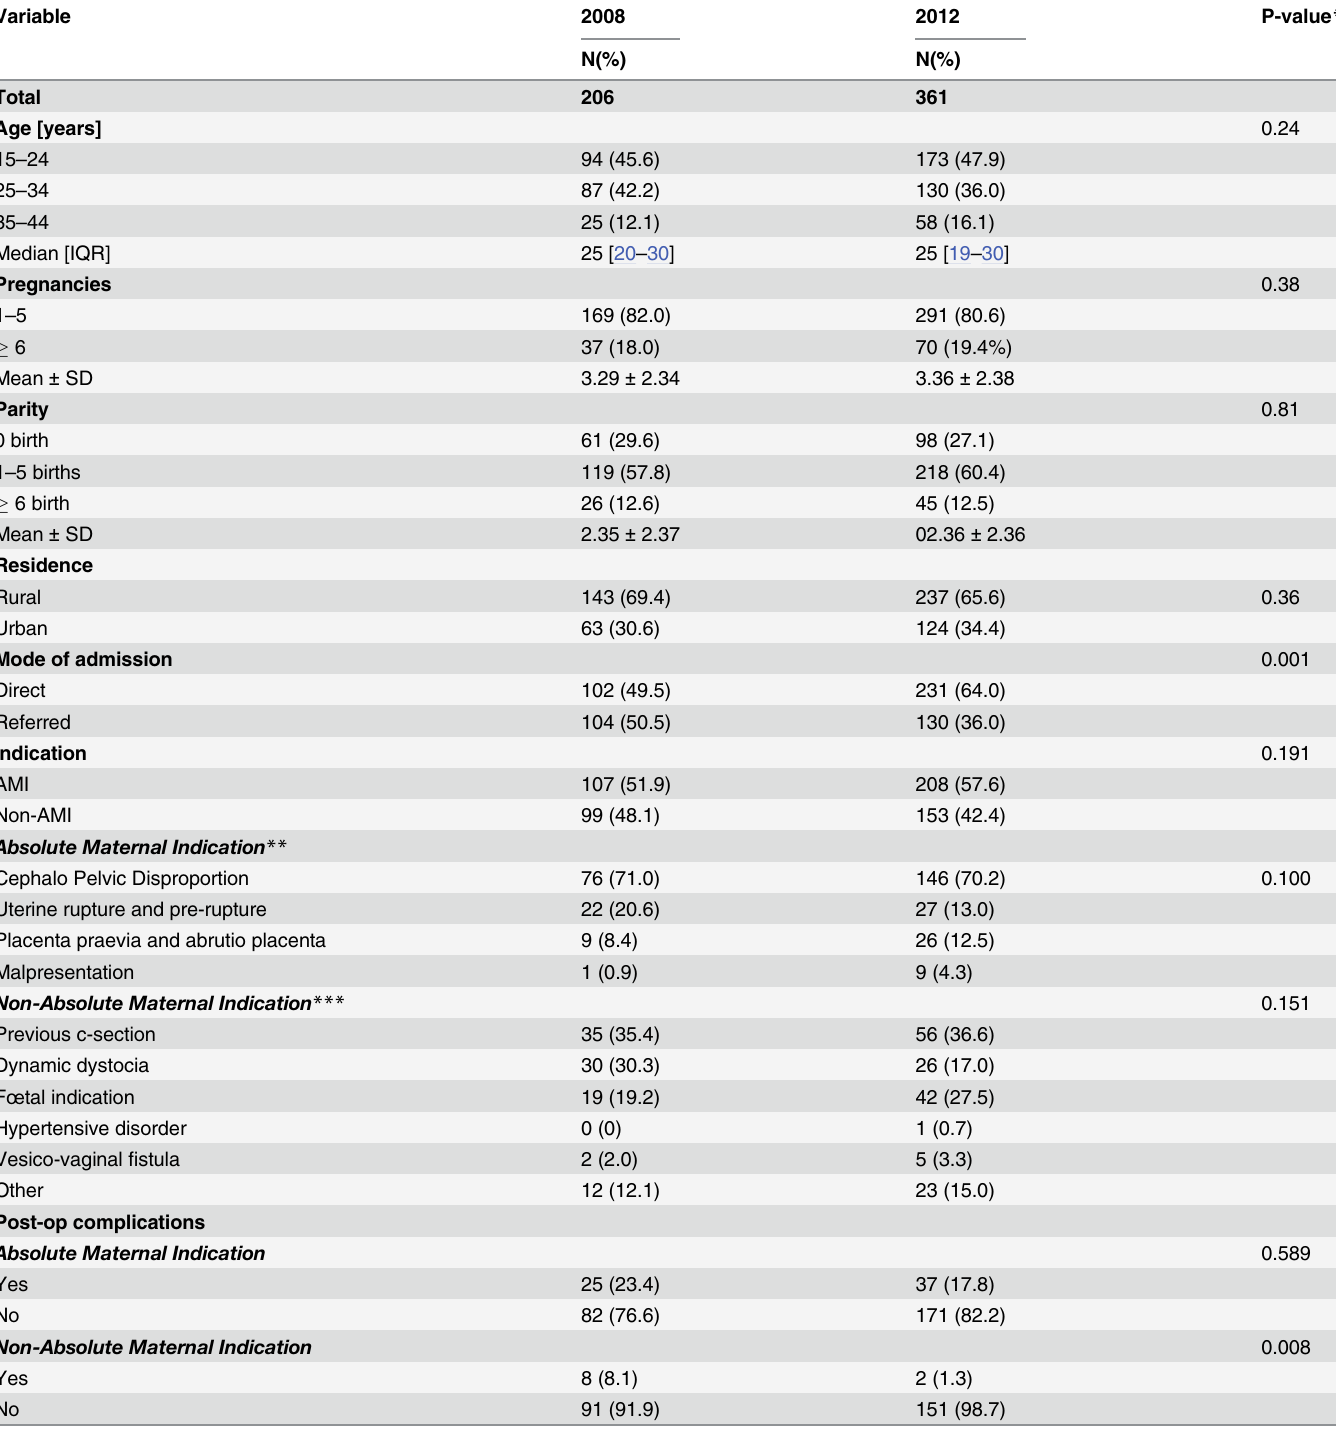
Table 1. Demographics and clinical characteristics of patients before and after the adoption of the policy at Kissidougou District Hospital in 2008 and 2012.